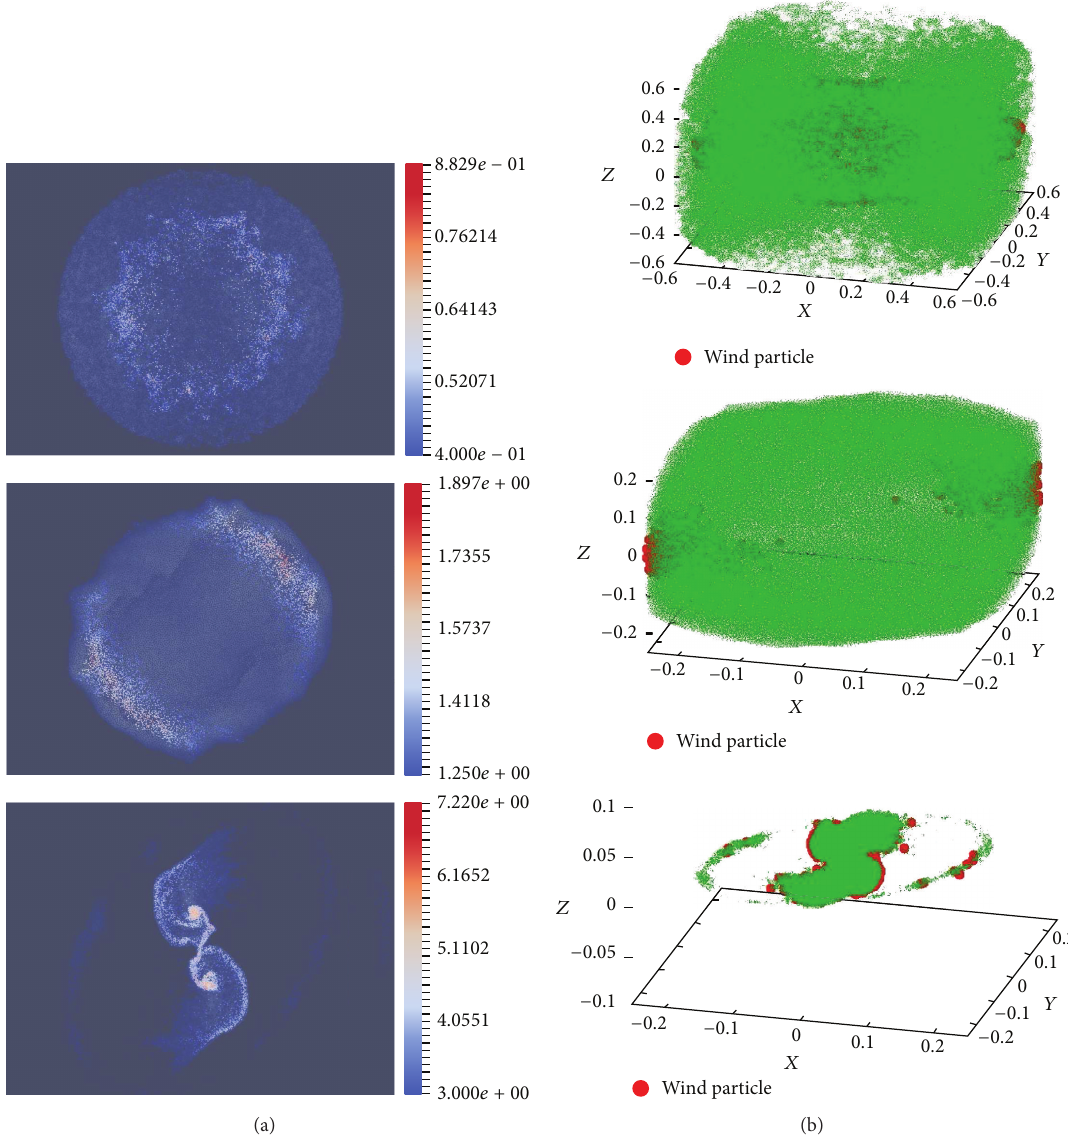
Figure 16: For Figures 13(b), 13(c), and 13(d) we show the following: (a) colored iso-density plots of the wind particles (shown in bright blue) in their diffusion process through the core particles (shown in opaque blue); (b) the position of wind particles shown in red and that of the core particles shown in